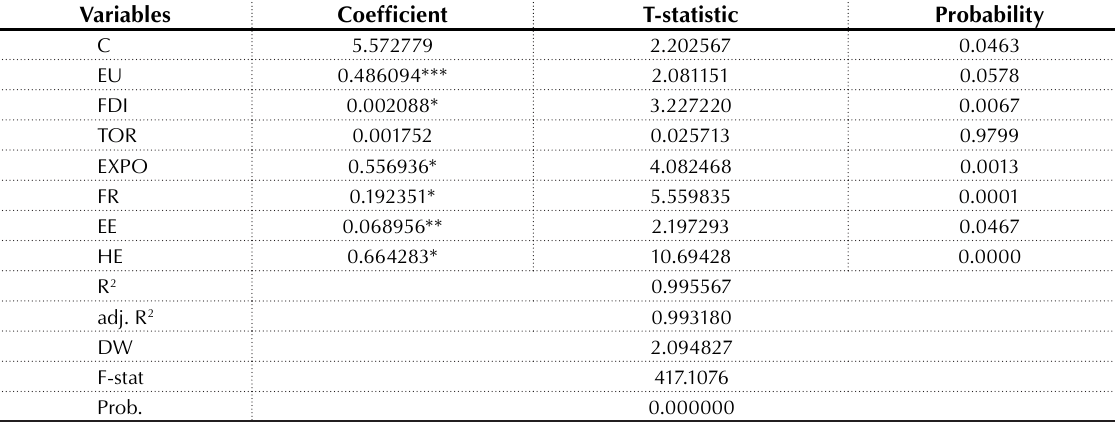
Table 3. Regression